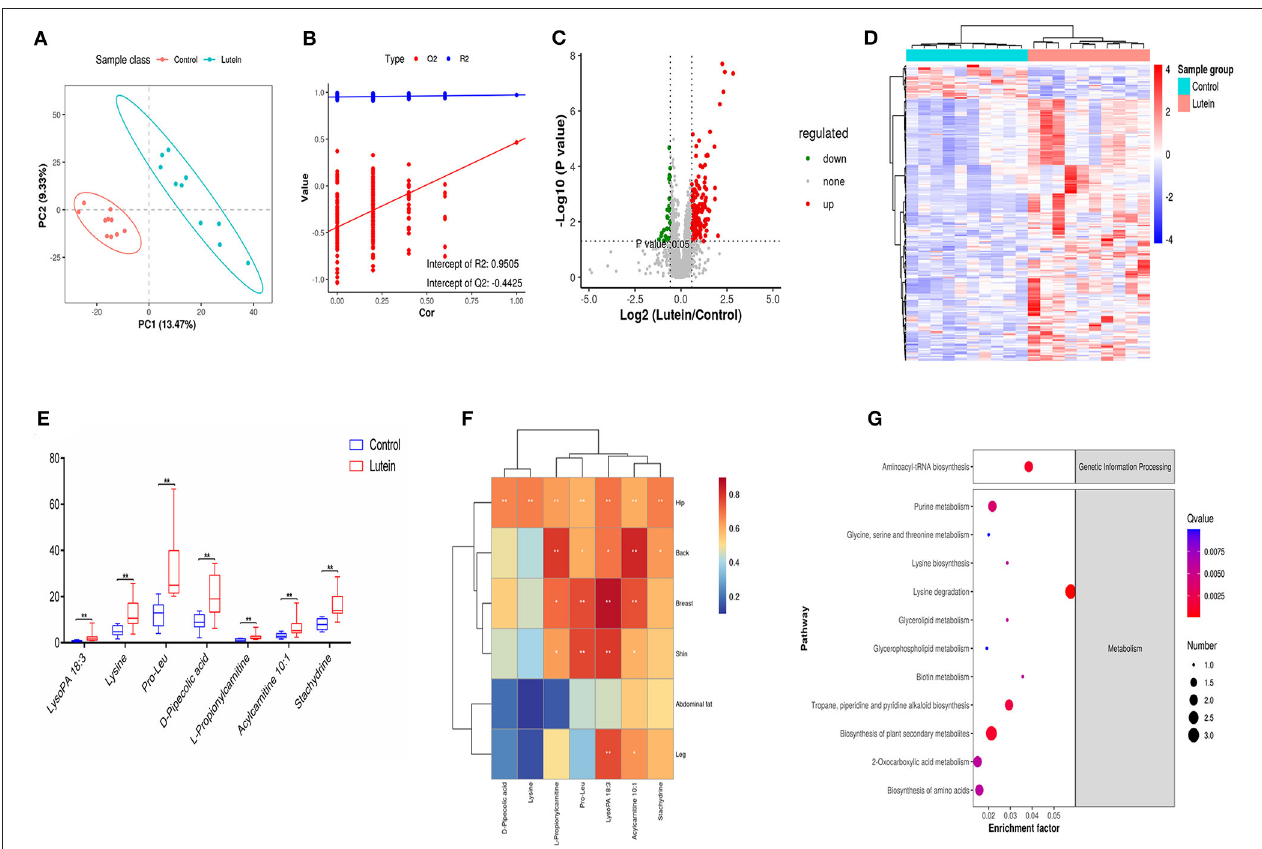
FIGURE 5 | Metabolome changes induced by lutein. (A) PLS-DA score plots in chicken plasma induced by lutein. Each point represents a sample, and the degree of dispersion of the two colors represents the distribution trend of the two groups on the PC1 and PC2 axes. (B) Permutation test of the PLS-DA model. The number of random permutation tests is 200. (C) Volcano map of different metabolites. The horizontal axis represents the fold change of metabolic ions in the comparison group, and the vertical axis shows –log 10 ( q -value). (D) Heatmap of the relative abundance of differential metabolites (VIP ≥ 1, q -value ≤ 0.05). Red indicates high relative abundance, and blue indicates low relative abundance. (E) Box plot of potential metabolites in the two groups. ** P < 0.01. (F) The correlation between skin yellowness and SDMs. The color from blue to red indicates a negative correlation to a positive correlation, * P < 0.05, ** P < 0.01. (G) KEGG pathway of differential